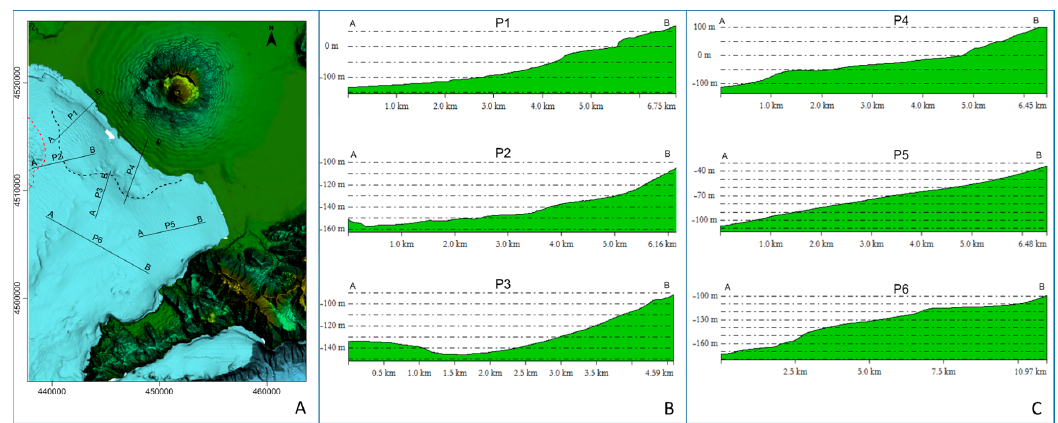
Figure 2. Location map ( A ) and profiles ( B , C ) extracted by Digital Terrain Model. The red dashed line refers to the boundary of Banco della Montagna, the black dashed line to the boundary of Somma-Vesuvius distal products. See text for further details.